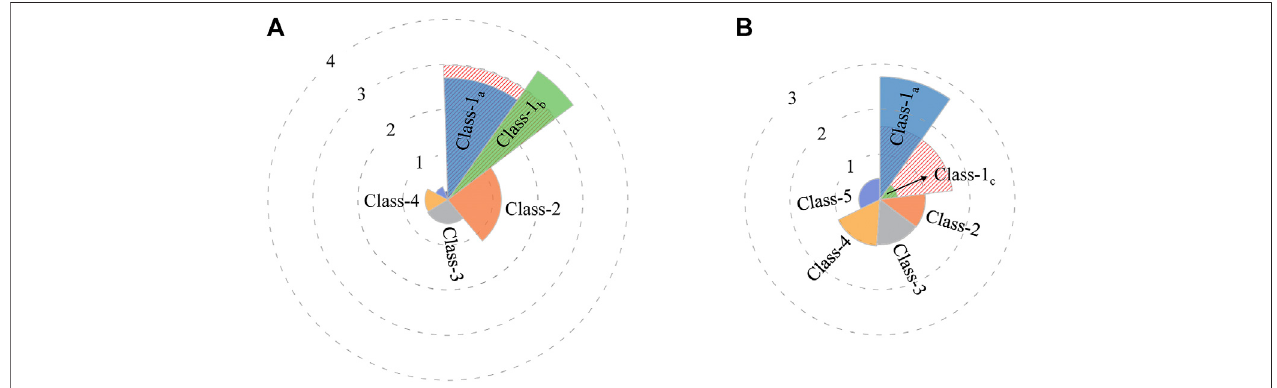
Figure 5 , after reclassi fi cation of altitude-class-1 and rivers- class-1, the accuracy of LSM based on the FR model was improved by 0.5% (72.8 – 73.3%), and the accuracy of LSM based on the RF model was signi fi cantly improved by 5.1% (79.9 – 85.0%).